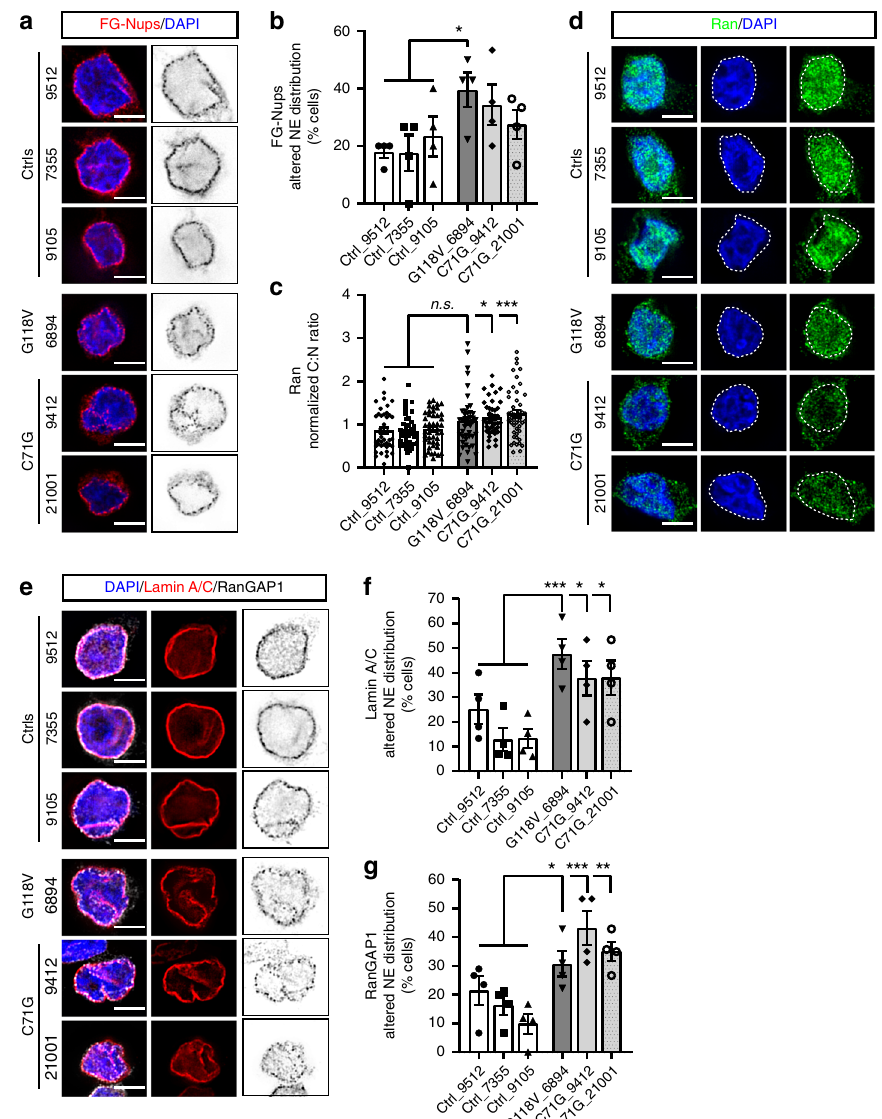
Fig. 3 NPC composition is altered in patient-derived lymphoblast cells. Immuno fl uorescence analyses and quanti fi cation of the localization of FG-Nups ( a , b ; red), Ran C:N ratio ( c , d ; green), Lamin A/C ( e , f ; red) and RanGAP1 ( e , g ; black) reveal alterations to the NPC composition in lymphoblast cells derived from 3 ALS patients carrying PFN1 C71G or G118V mutation compared to 3 control lines. Quanti fi cations show an increase in the percentage of cells with disrupted Lamin A/C and RanGAP1 staining for all lines, while FG-Nups and Ran were signi fi cantly altered only in the G118V or C71G mutant lines, respectively. Bars are mean ± SEM. * p < 0.05, ** p < 0.01, *** p < 0.001, n.s. non-signi fi cant. N = 4 independent experiments ( b , f , g ); 45 – 48 cells from 3 independent experiments ( c ). DAPI ( blue ) was used to dete c t the nucleus and assess cell health. Scale bars: 10 µ m. See also Supplementary Fig. 6